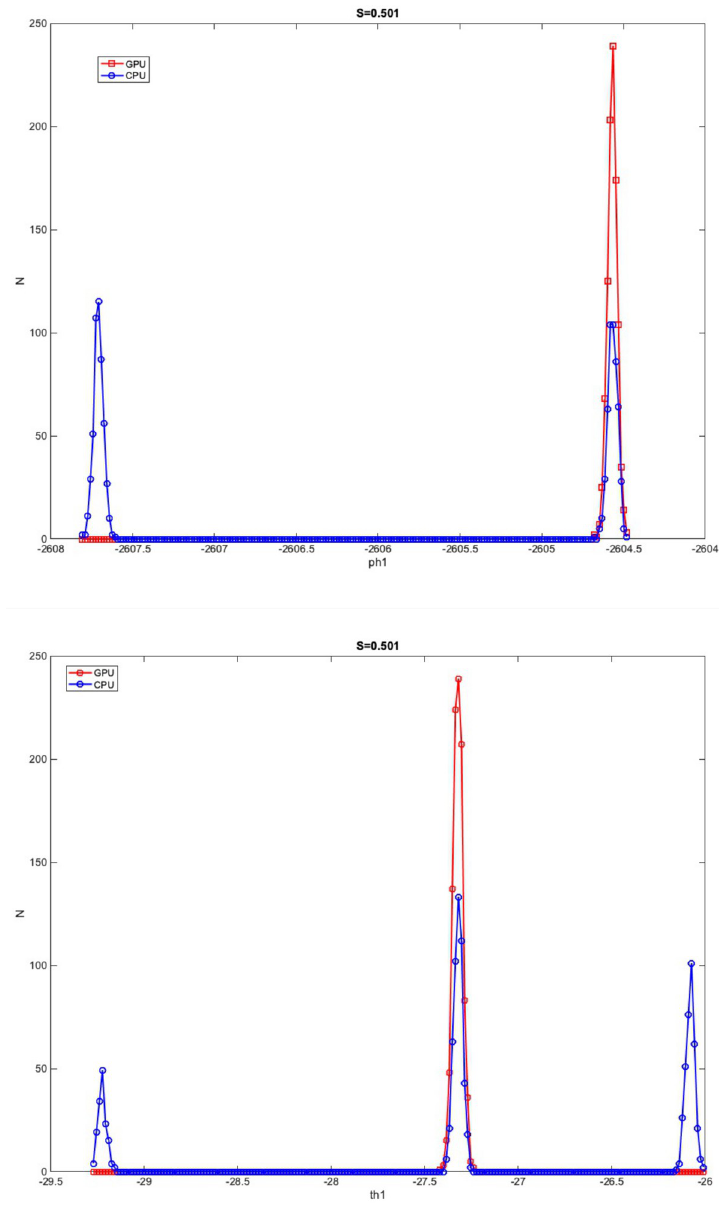
Fig 7. Distribution shape of ϕ 1 and θ 1 . Distributions of ϕ 1 and θ 1 that are significantly different were derived from one representative voxel with a particularly high S-score of 0.501. The voxel was located within the corpus callosum. Red squares and line denote GPU samples while blue circles and line denote CPU